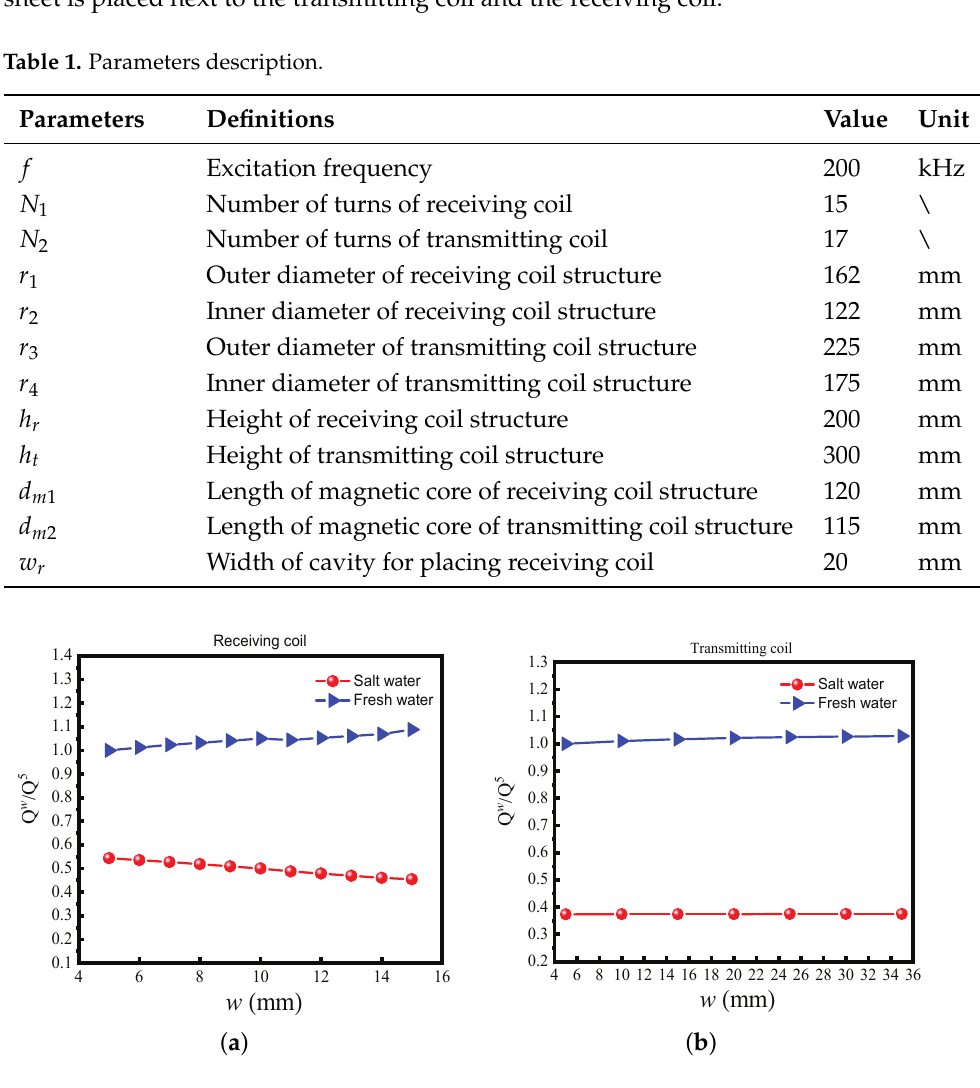
Figure 3. Variation of the normalized quality factor of the coils with thickness w of the magnetic core. The conductivity of the fresh water is σ = 0.0001 S/m, and the conductivity of the salt water is σ = 4 S/m. ( a ) Receiving coil. ( b ) Transmitting